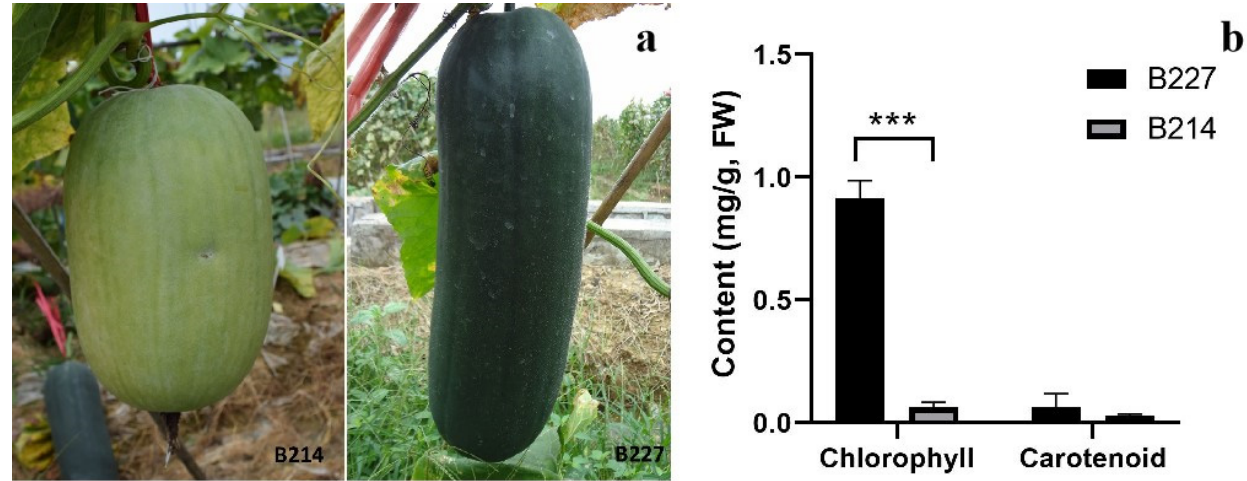
Figure 1. Phenotypic differences between mature fruit of B214 and B227: ( a ) Images of mature fruit of B214 (left) and B227 (right). ( b ) Chlorophyll and carotenoid content of mature pericarp of B214 and B227. FW, fresh weight. ***, p < 0.001.